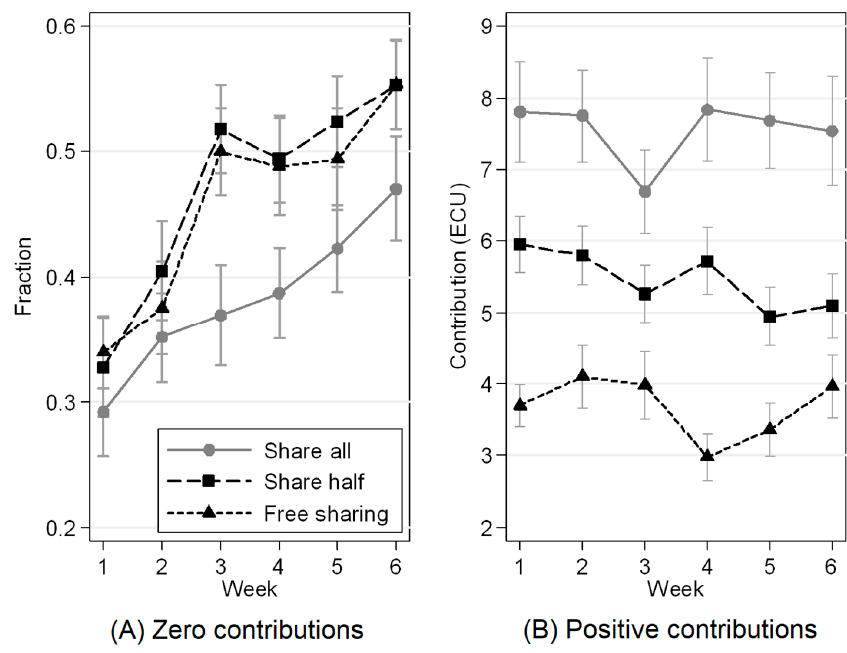
Figure 2. Zero and positive absolute contribution over time. Effect of time on the three sharing rules: Free sharing (R1, triangles), Share Half (R2, squares) and Share All (R3, circles). Standard error bars in gray. ( A ) Waiters’ relative frequency of zero contributions were 44% of the total and the percentage increased with time. ( B ) Waiters’ non-zero contributions in ECU varied across sharing rule but not over time. Table 1. Hurdle model. A. Panel data random-e ff ects logistic regression on waiters’ zero